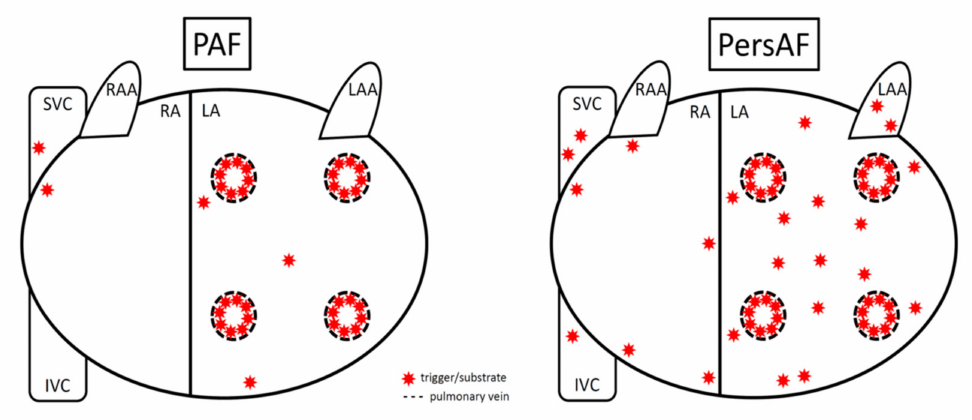
Figure 2. Triggers and substrates for PAF vs. PersAF. In PAF, the majority of these are located within and around the PVs, whereas in PersAF there are many more non-PV locations, especially in the posterior wall (between the four PVs and below the lower PVs). LA, left atrium; LAA, left atrial appendage; RA, right atrium; RAA, right atrial appendage; SVC, superior vena cava; IVC, inferior vena